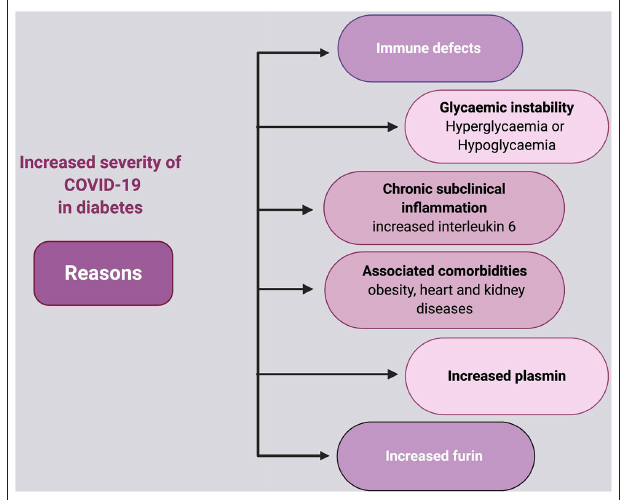
FIGURE 1 | Viral entry mechanism to the